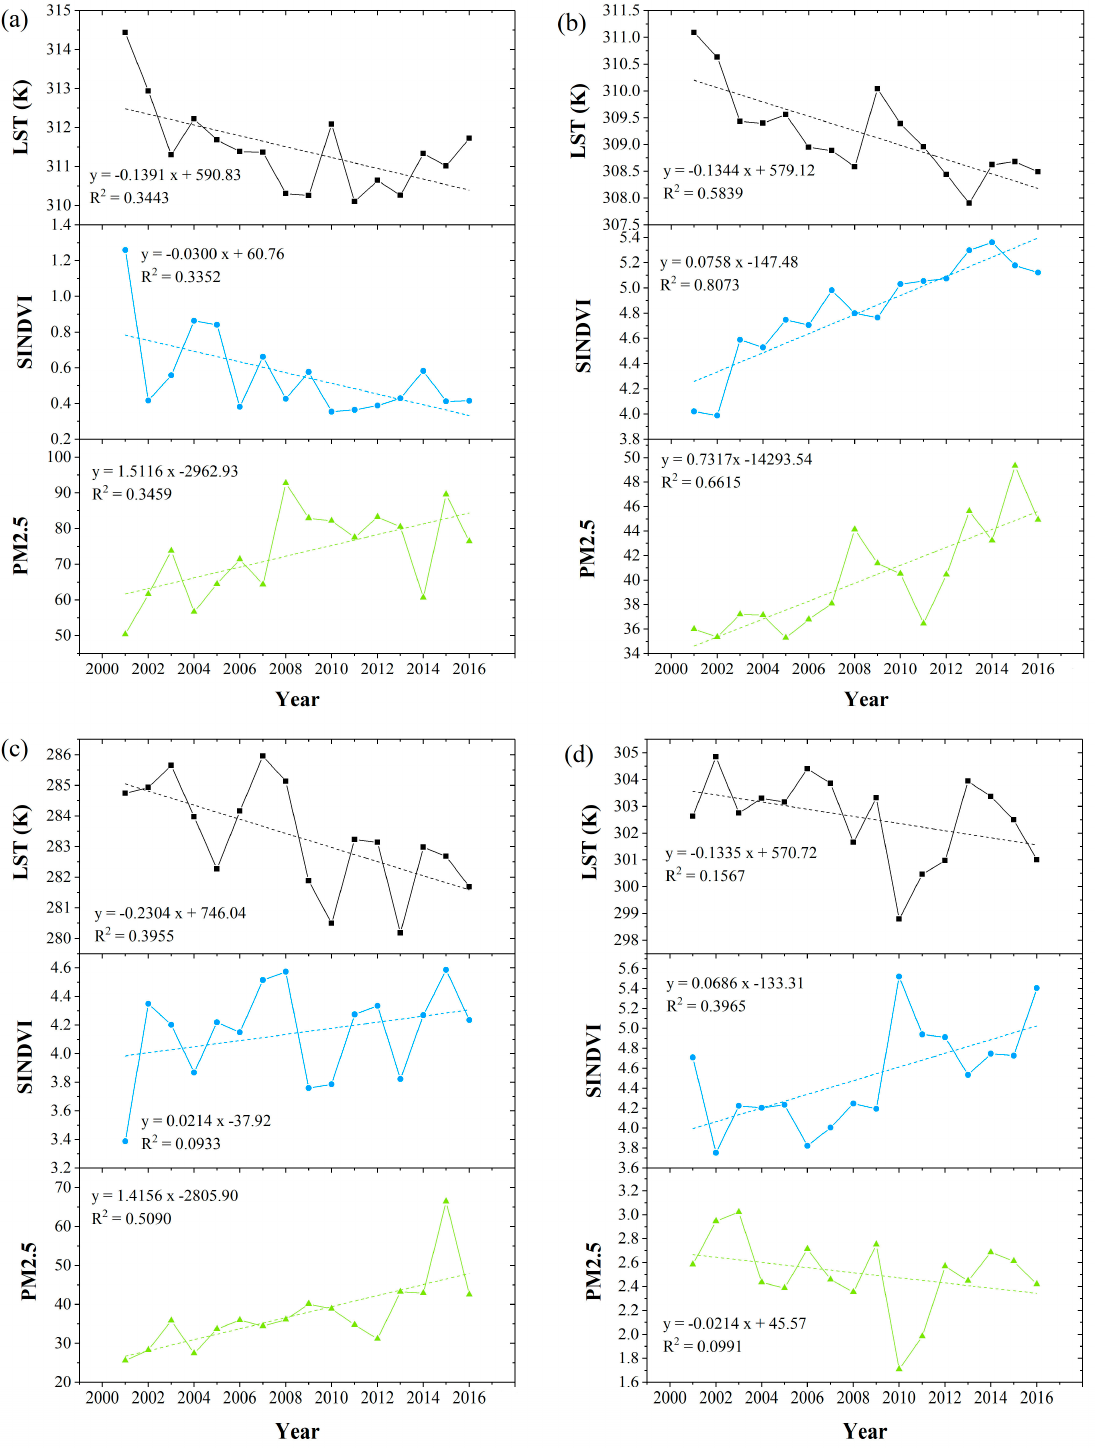
Figure 4. The temporal changes of LST, SINDVI, and PM 2.5 in regions of interest (ROIs), which were shown in Figure 1a in yellow. ( a ) ROI-a in Saudi Arabia, ( b ) ROI-b in India, ( c ) ROI-c in China, and ( d ) ROI-d in Australia.